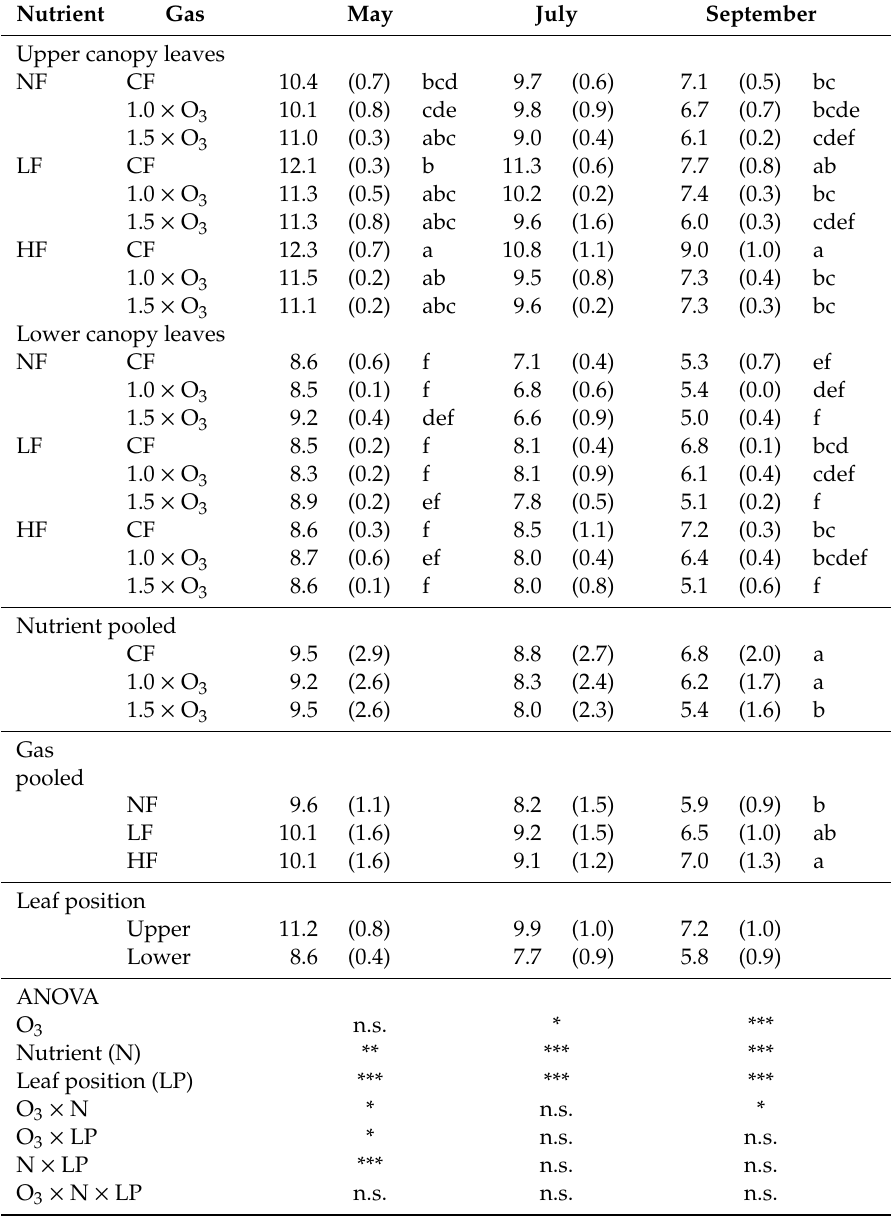
Table 3. Light-saturated net photosynthetic rate ( µ mol m − 2 s − 1 ) in upper and lower canopy leaves of Siebold’s beech